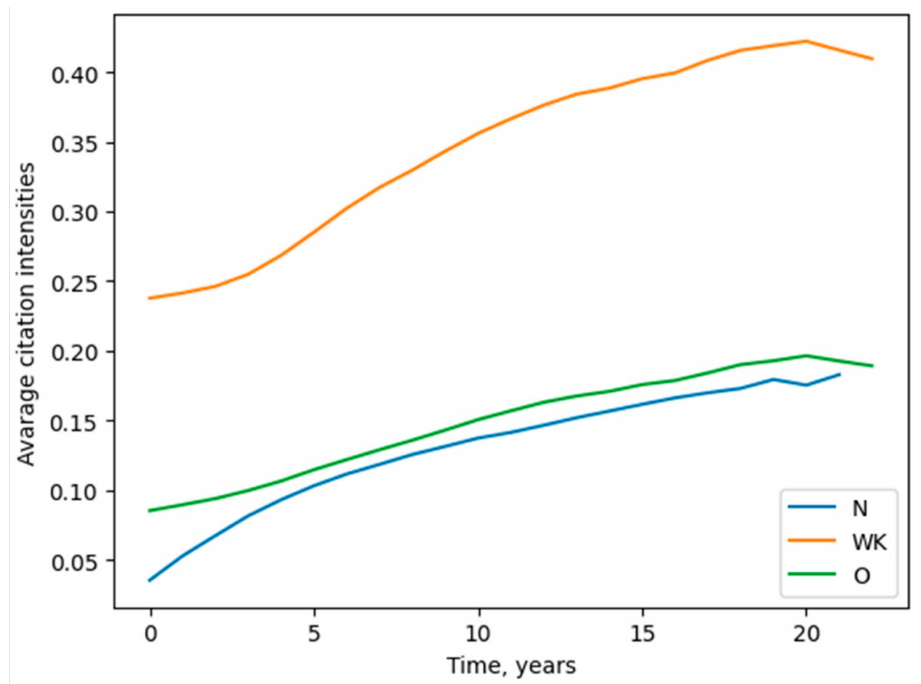
Figure 2. Comparison of average citation intensities of collective subjects belonging to classes N, WK, O, λ =